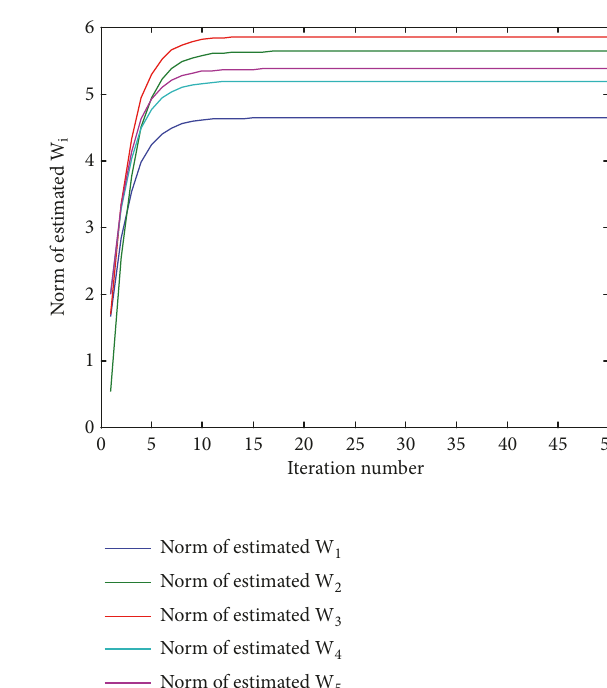
Figure 7: Response of estimated